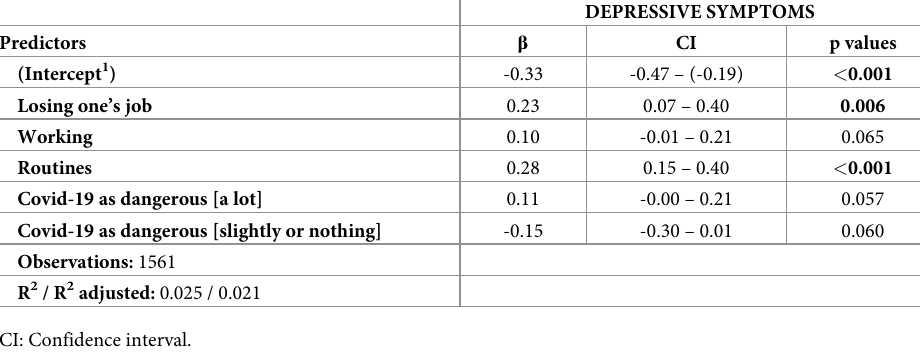
Table 13. Regression analysis relating to depressive symptomatology in the